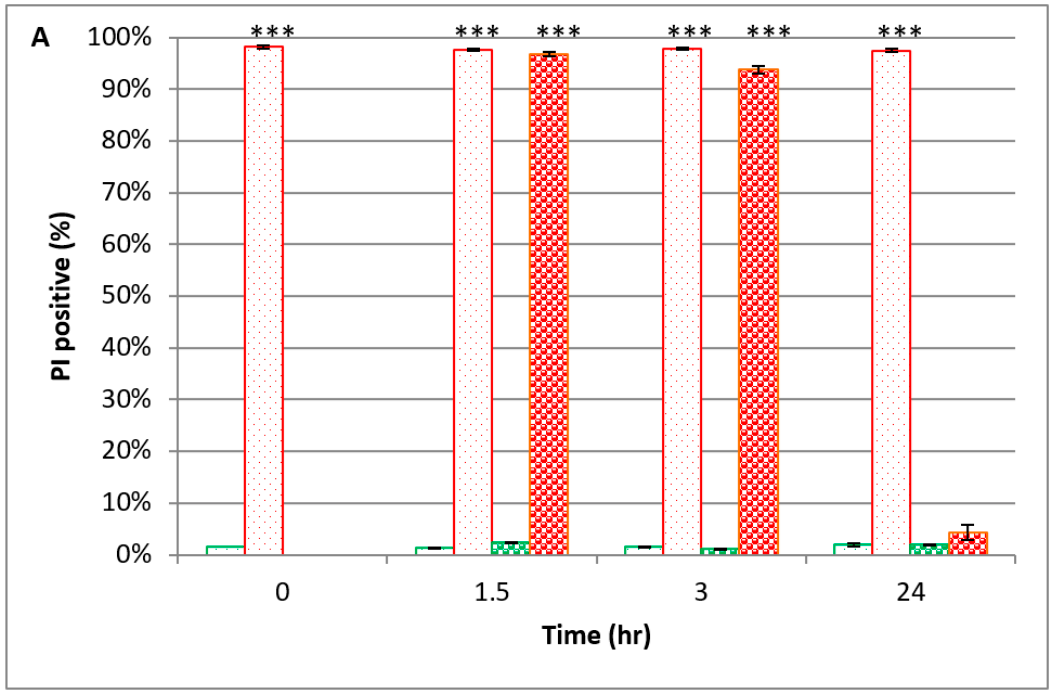
Figure 5. Examination of S. cerevisiae membrane permeability. PEF-treated yeasts, which were suspended in YMB (1.5–24 h) (